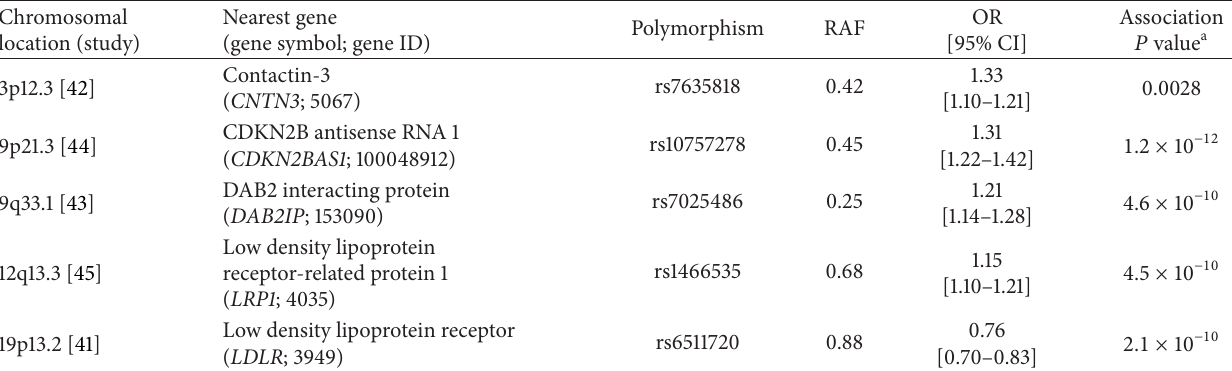
Table 2: AAA genetic loci discovered using genome-wide association